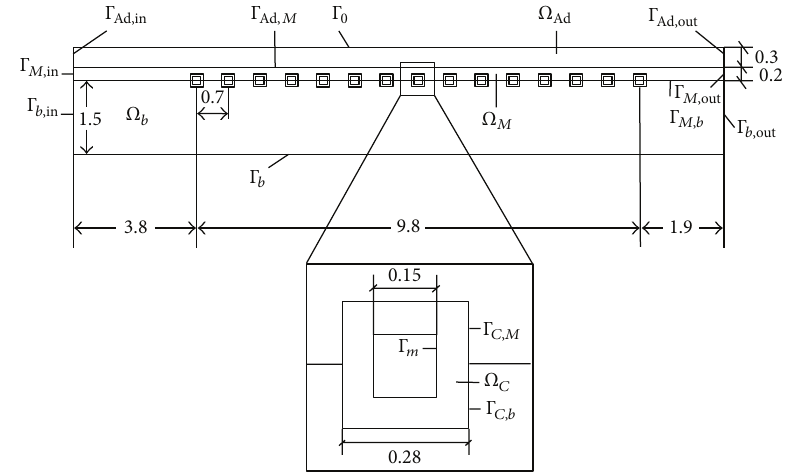
Figure 1: 2D simplified